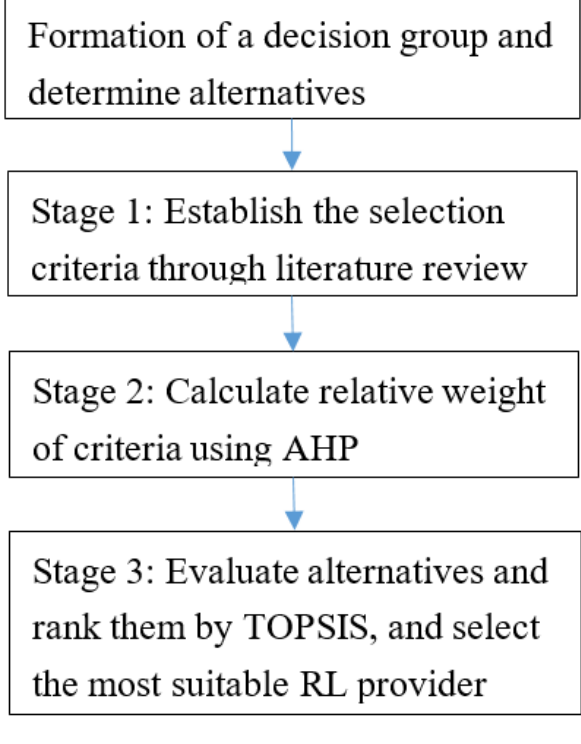
Figure 1. Proposed research framework for RL provider selection.